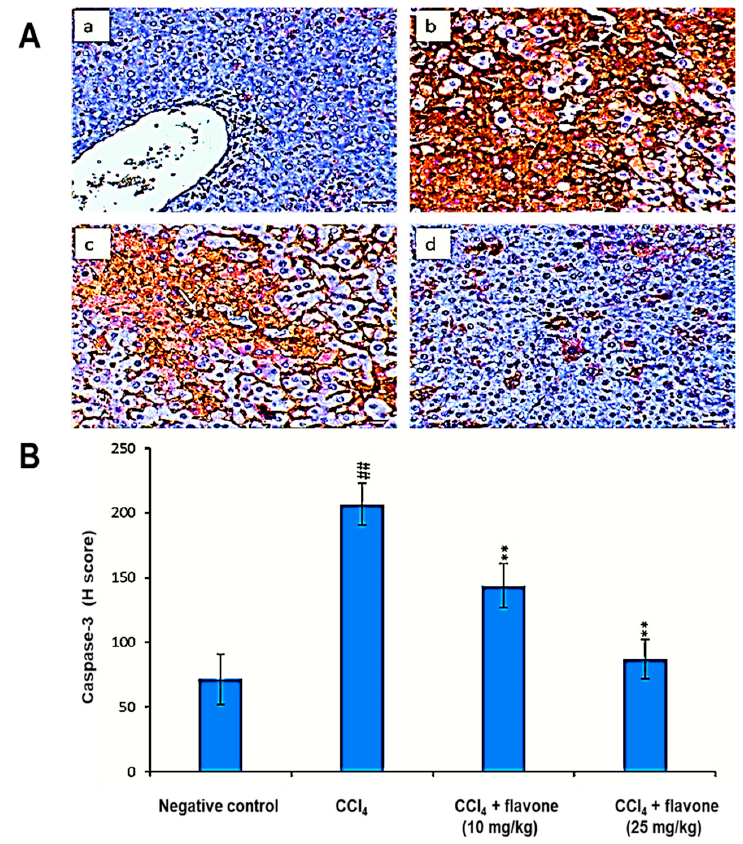
Figure 4. Effect of treatment with the flavone on the caspase-3 protein level in liver tissues. A : Representative liver immunohistochemical graphs (a: control group, b: carbon tetrachloride (CCl 4 ) group, c: CCl 4 + flavone (10 mg/kg) group, d: CCl 4 + flavone (25 mg/kg) group); ( a ) showed a noticeable